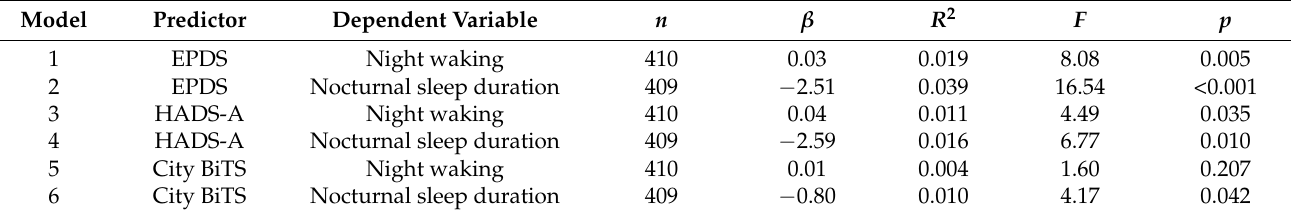
Table 2. Simple Linear Regression